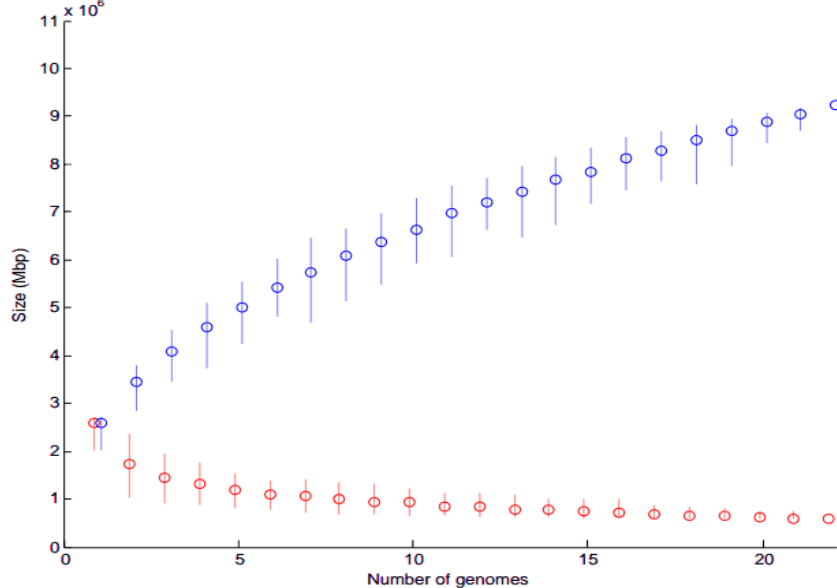
Figure 4. Core and pan-genome model of 22 A. oris strains. * Core and pan-genome size is plotted as a function of a number (n) of genomes added. Circles are the average of such values. A red circle represents core genomes while a blue circle represents pan genomes of Actinomyces .